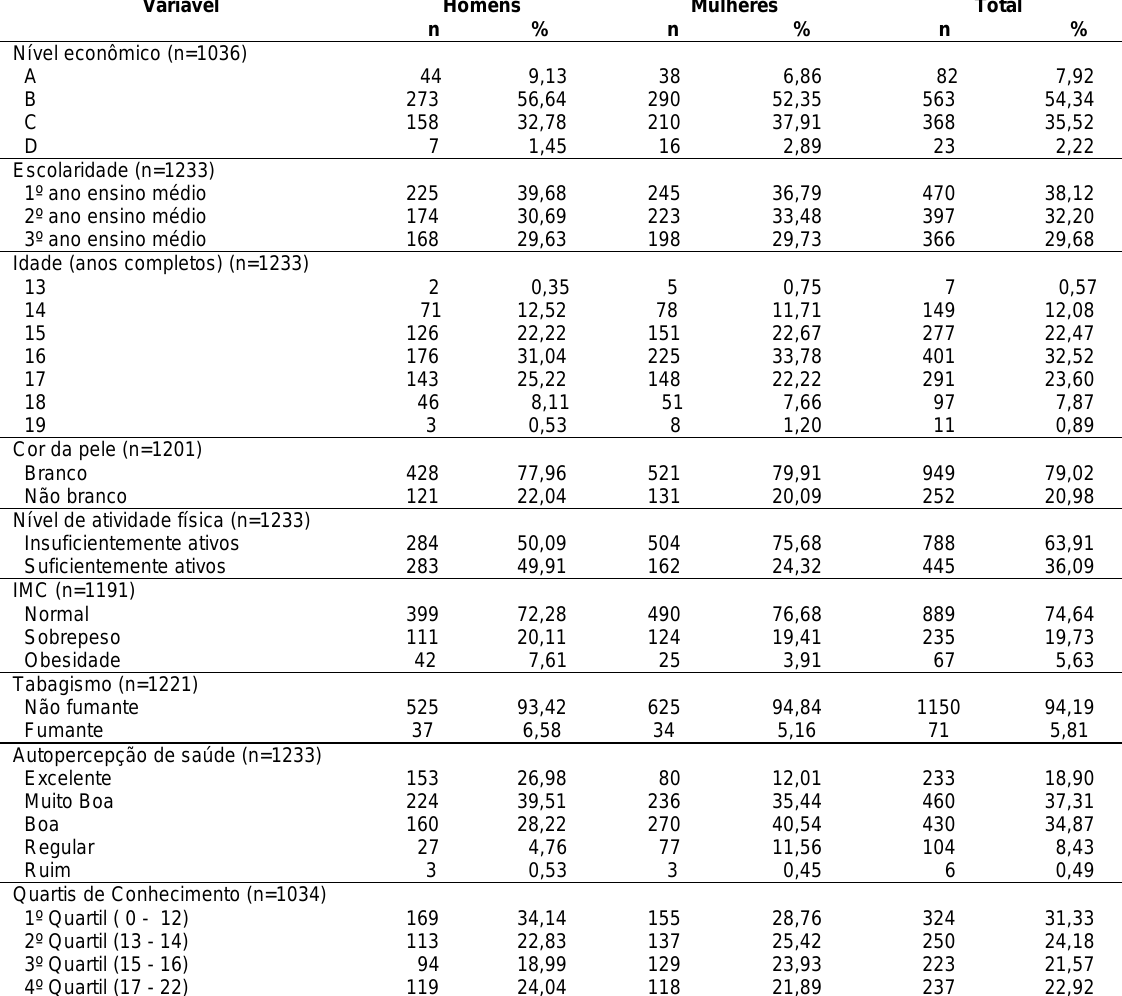
Tabela 1. Descrição da amostra de escolares adolescentes estratificada por sexo, cursando ensino médio nas escolas da cidade de Pelotas/RS/Brasil (n=1233) segundo variáveis sócio-econômicas,